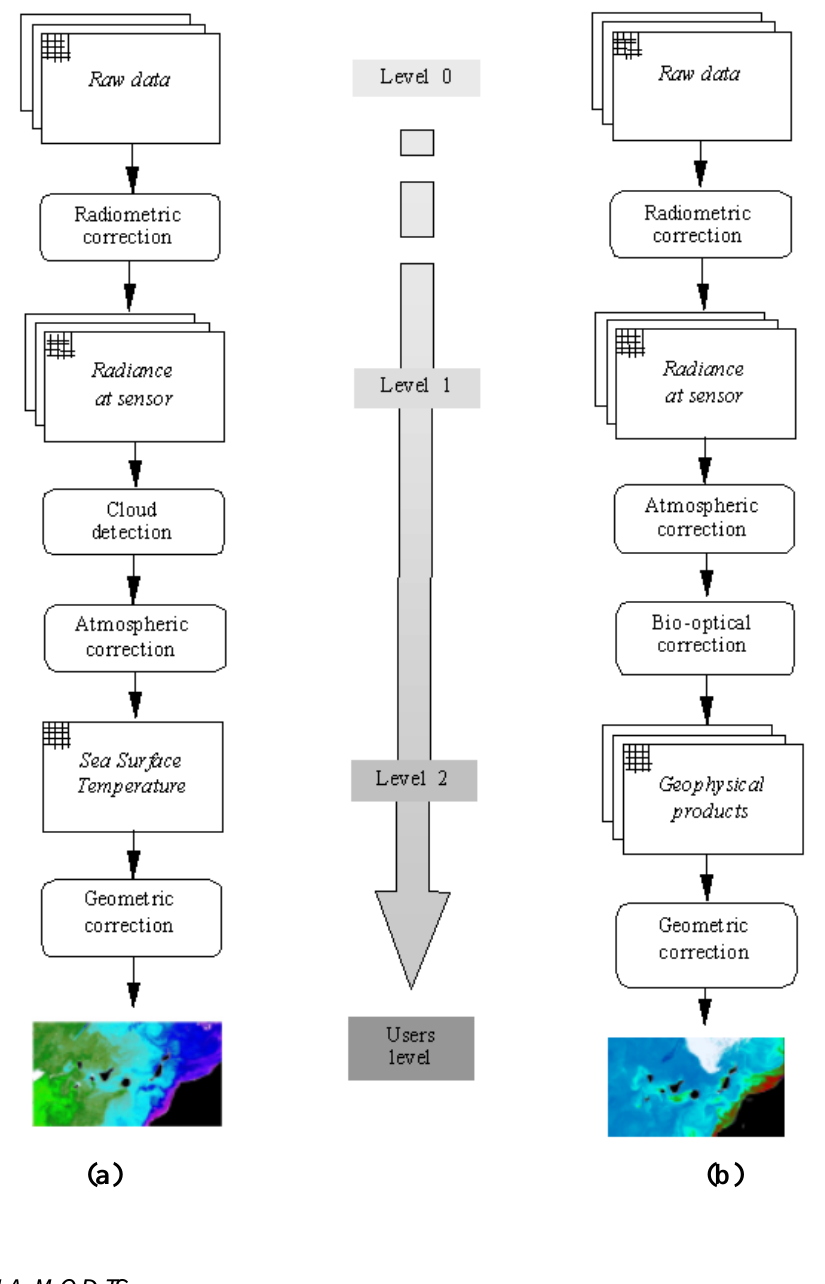
Figure 2. Processing levels hierarchy. (a) NOAA-AVHRR data and, (b) SeaStar-SeaWiFS